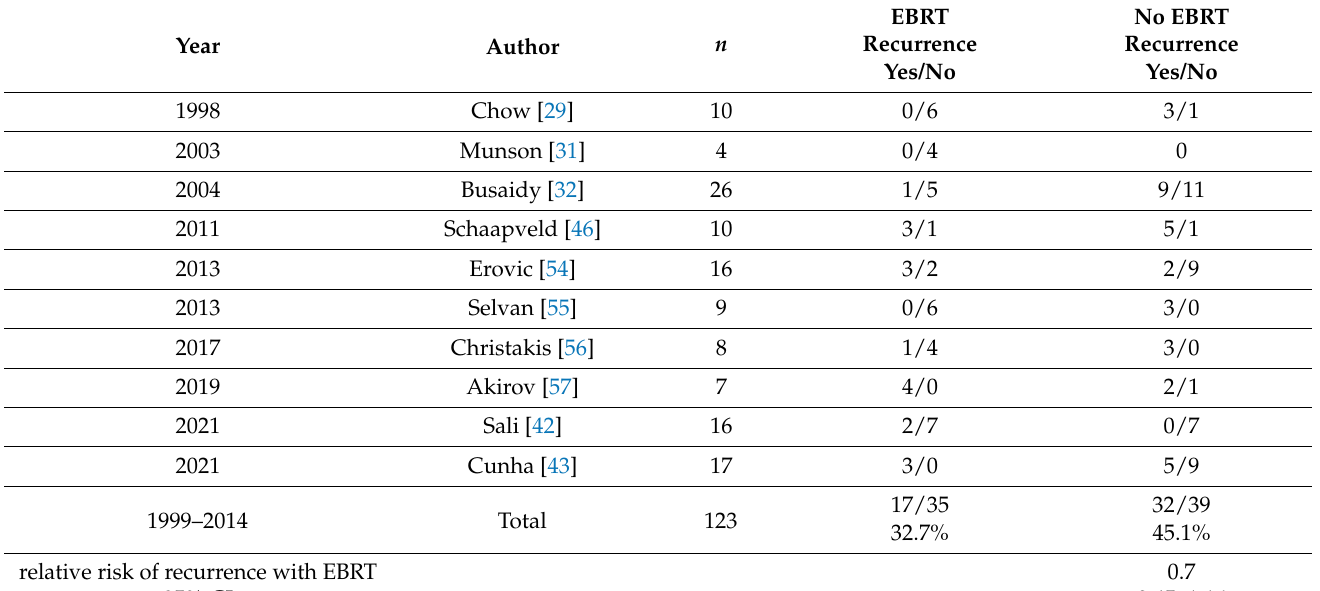
Table 8. Outcomes following adjuvant radiotherapy after initial surgery reported in the